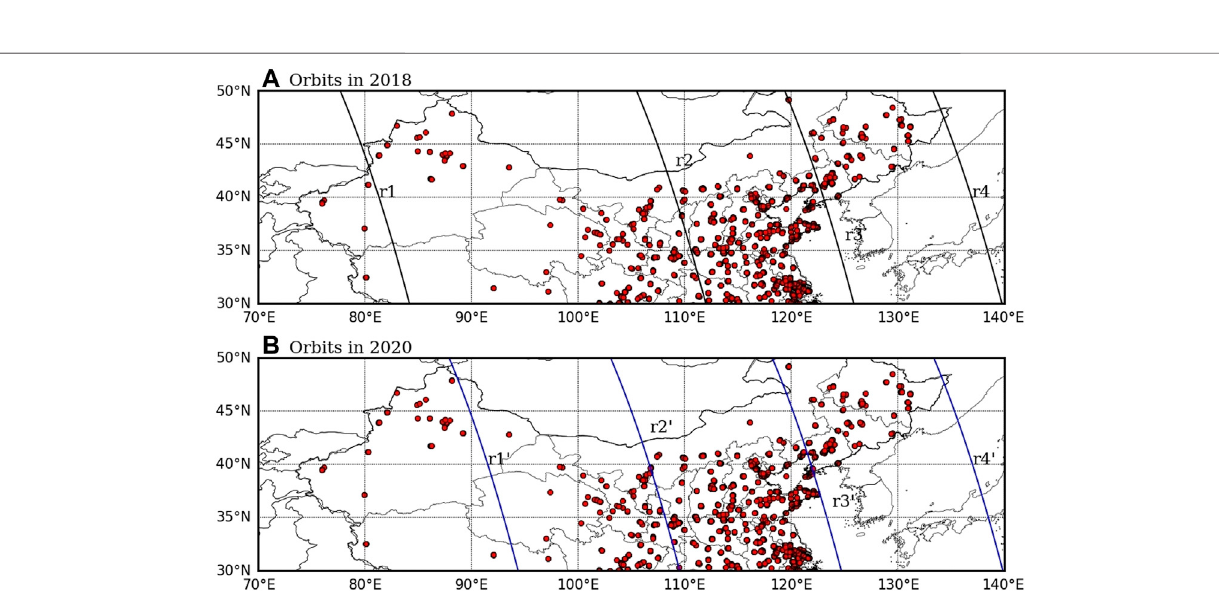
Frontiers in Environmental Science |